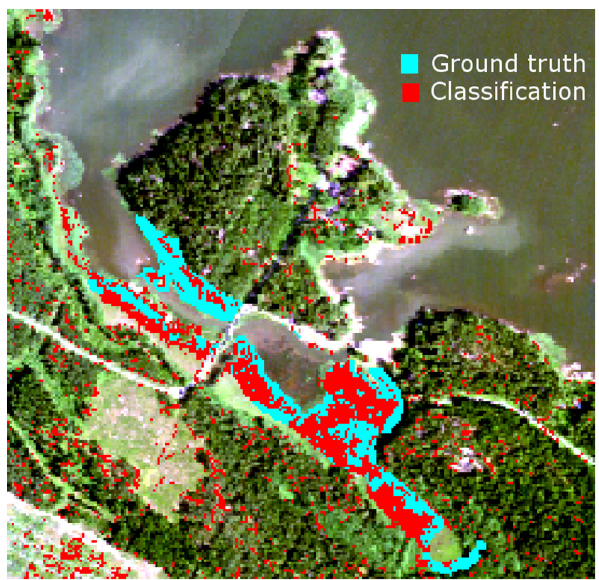
Figure 10. The classification results using the mean spectrum of Kornamaa. Table 13. Classification accuracy of reed beds at site Kornamaa.